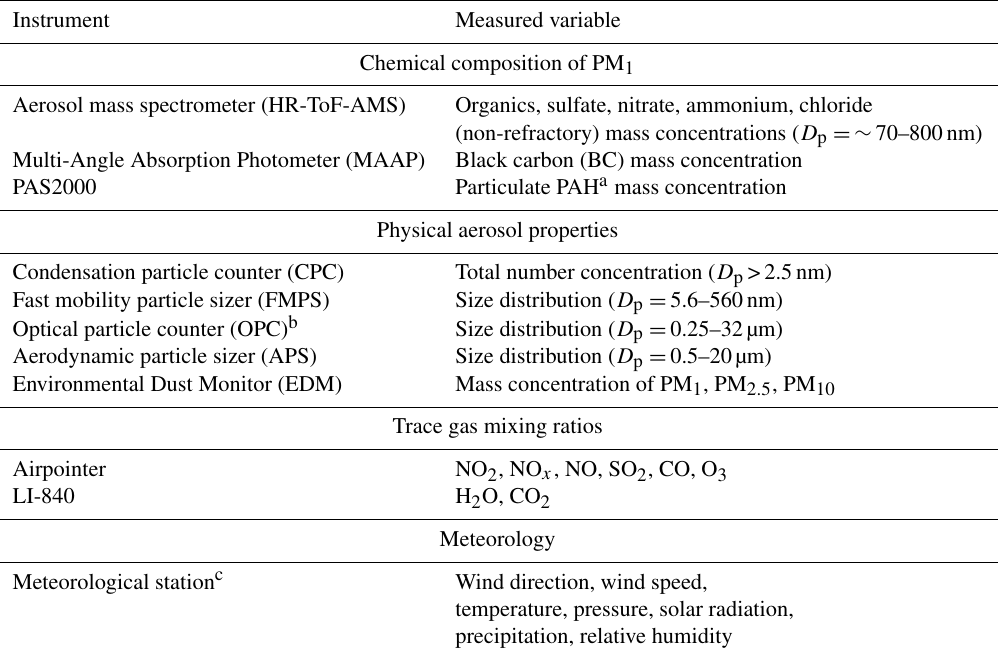
Table 2. Summary of the instruments deployed in MoLa during all measurement periods, together with measured variables. D p : particle diameter (defined according to individual instrumental measurement method: optical, aerodynamic or mobility